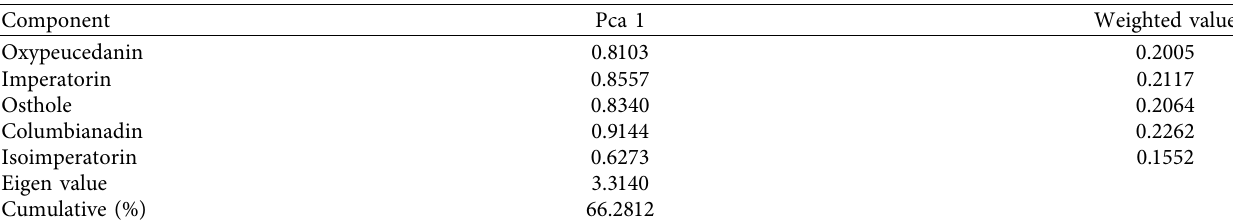
Table 4: Principal components and weights of APR in different origins.